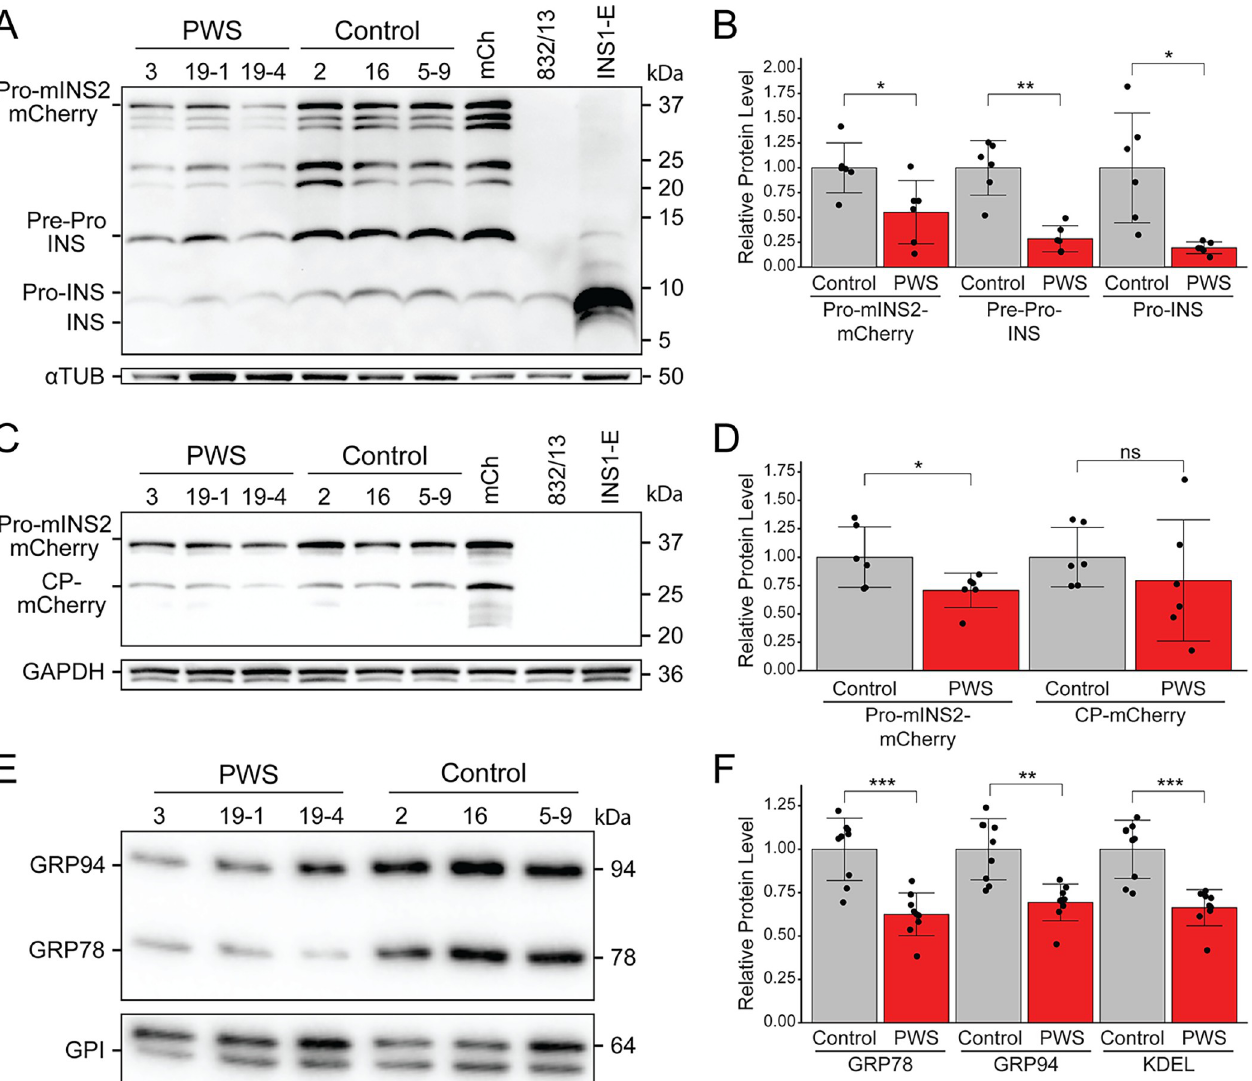
Fig 5. Reductions in insulins and ER chaperone levels in PWS-deletion vs . control INS-1 lines. Western blots of whole cell lysates from PWS (3, 19–1, 19–4) and control (5–9, 2, 16) INS-1 β -cell lines grown under control (DMSO) conditions for 5 h were assessed using a panel of antibodies. (A) Anti-insulin, detecting all cellular forms of insulin (Pre-Pro-, Pro-, and fully processed rat INS) as well as mouse proinsulin2 (Pro-mINS2)-mCherry. (B) Quantitation of Pro-mINS2-mCherry, Pre-Pro-INS and Pro-INS detected with anti-insulin in the PWS and control INS-1 lines (n = 6 each genotype). (C) Anti-mCherry, detecting mouse proinsulin2 (Pro-mINS2)-mCherry and C-peptide (CP)-mCherry. (D) Quantitation of Pro-mINS2-mCherry and CP-mCherry detected with anti-mCherry in the PWS and control INS-1 lines (n = 6 each). (E) Anti-KDEL, detecting the two major ER chaperones GRP94 (endoplasmin; HSP90B1) and GRP78 (BiP; HSPA5). (F) Quantitation of GRP78, GRP94, and total KDEL detected with anti-KDEL in the PWS and control INS-1 lines (n = 9 each). Anti- α - Tubulin, anti-GAPDH, and anti-GPI were used as controls for protein loading levels in (A) , (C) , and (E) , respectively. For (A) and (C) , control cell lines included INS-1::mCherry (mCh), INS-1(832/13) parental, and INS1-E. In (A) , unlabeled bands likely are Pro-mINS2-mCherry proteolytic fragments not containing the anti-mCherry epitope, as not detected in (C) . For (B , D , F) ,statistical comparison by Welch’s t-test: * , P < 0.05; ** , P < 0.005; *** , P < 0.0005; ns, not